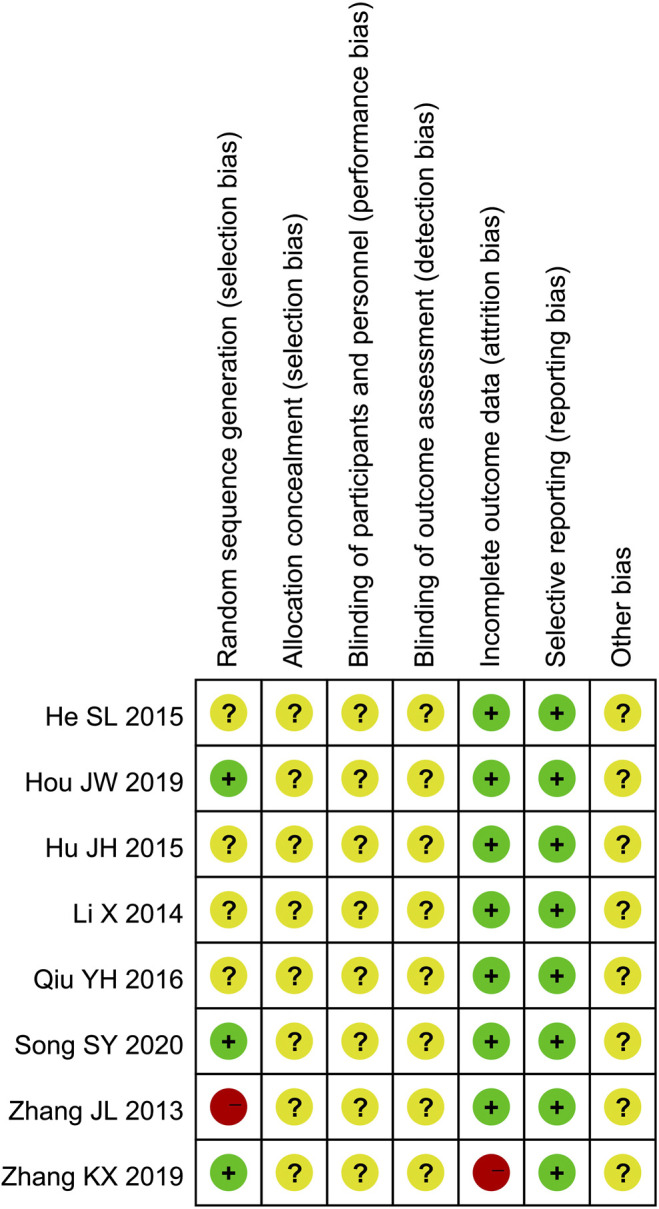
Risk of bias summary.